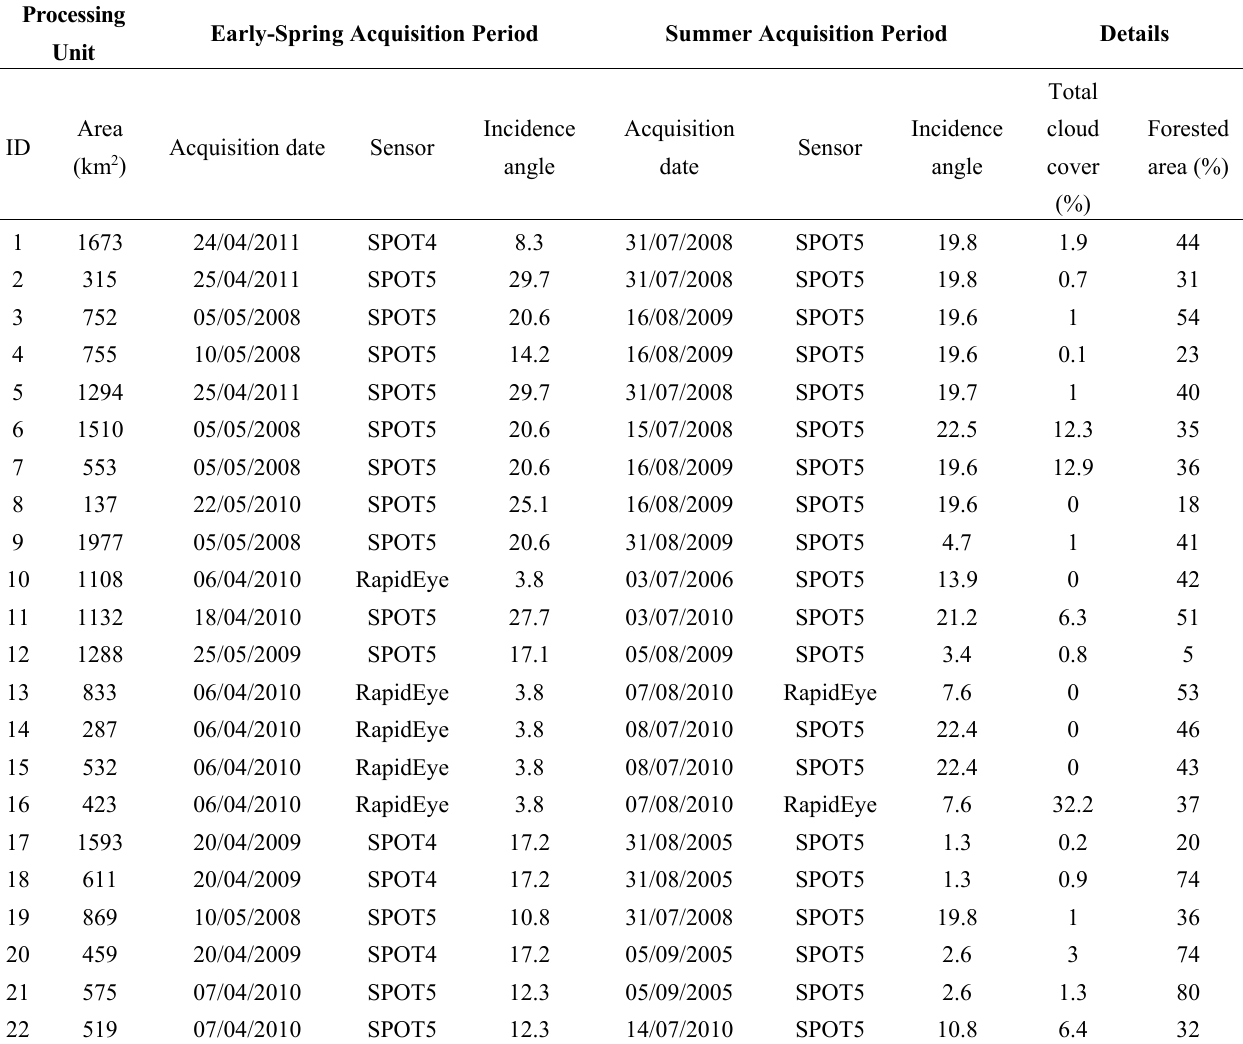
Table 1. Available satellite data and resulting processing unit